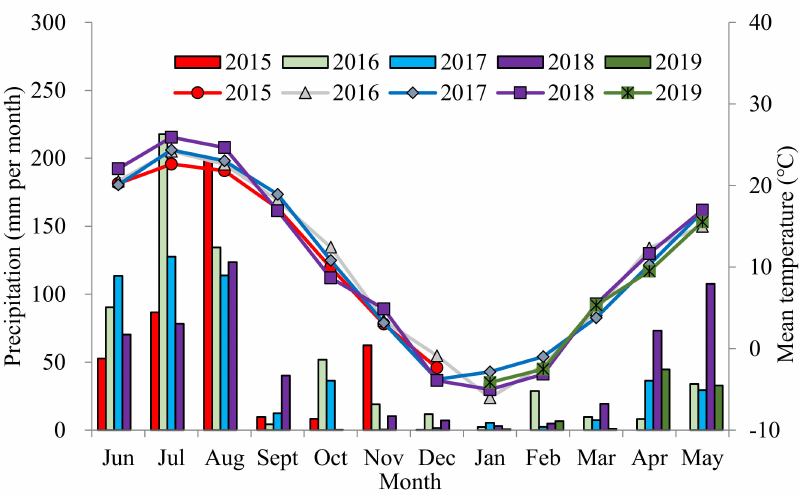
Figure 1. Monthly mean temperature and precipitation from June 2015 to June 2019 at the experi- mental winter wheat–summer maize rotation site in north-central